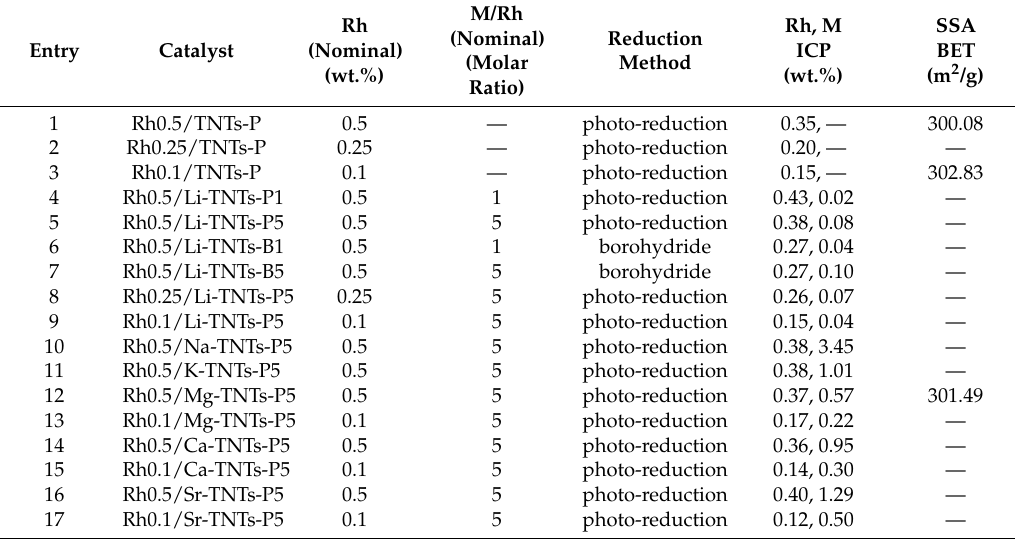
Table 1. The preparation method, the content of Rh or M (M = Li, Na, K, Mg, Ca, Sr.) promoters, and the specific surface area (SSA) of